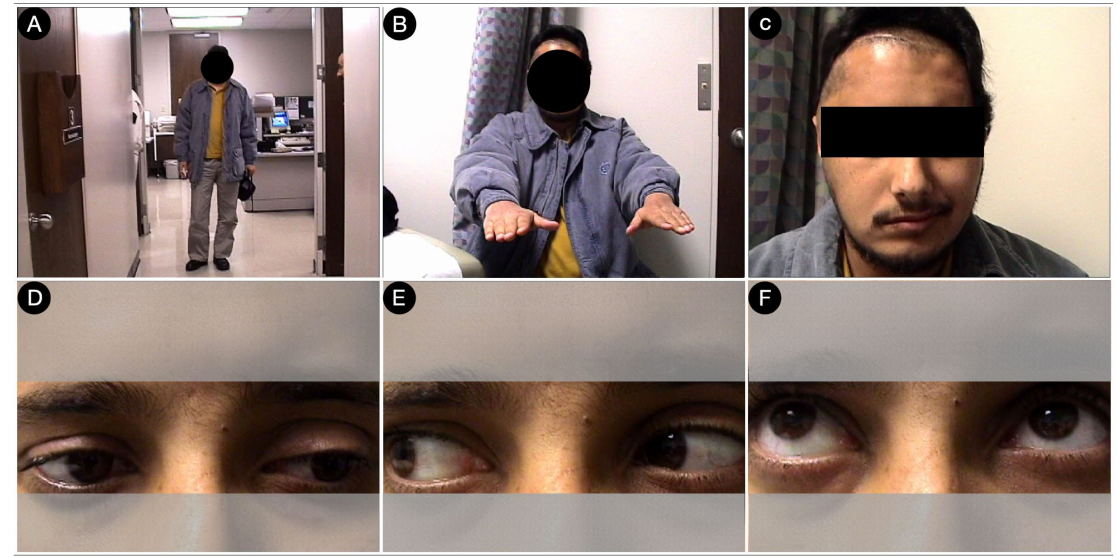
Figure 13. Postoperative pictures of the patients showing the motor ( A , B ), facial nerve ( C ), and oculomotor ( D – F )